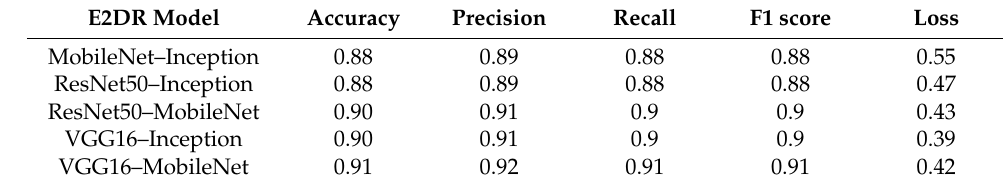
Table 4. E2DR models performance on the test set.